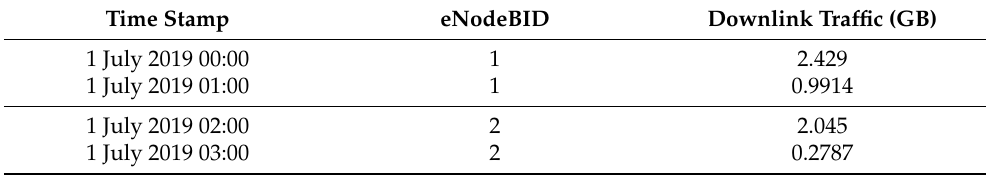
Table 1. Structure of wireless network data.